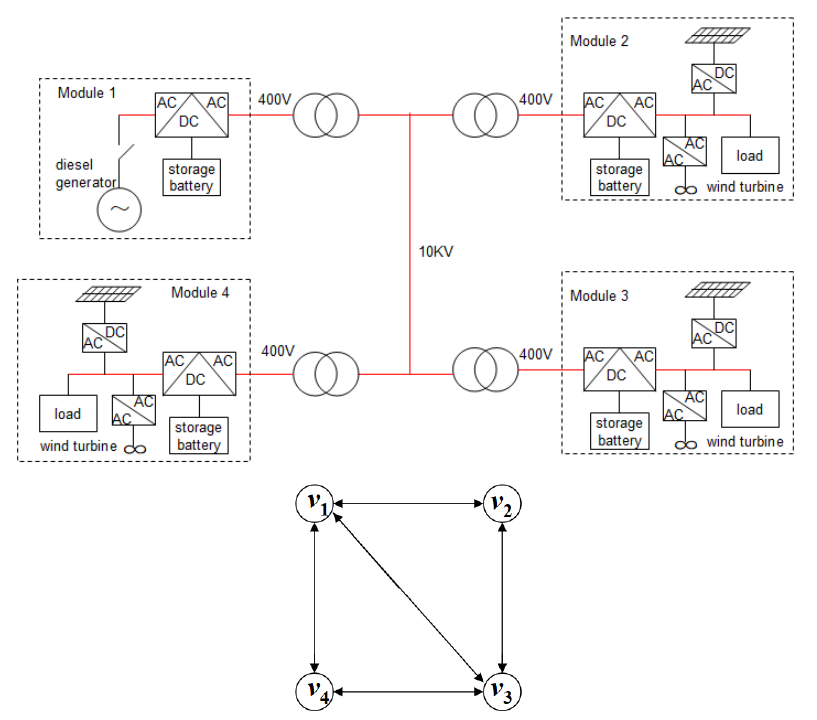
Figure 6. Above: structure of modular microgrid on DongAo Island; Below: communication network G , which is ( 2,2 ) -robust.